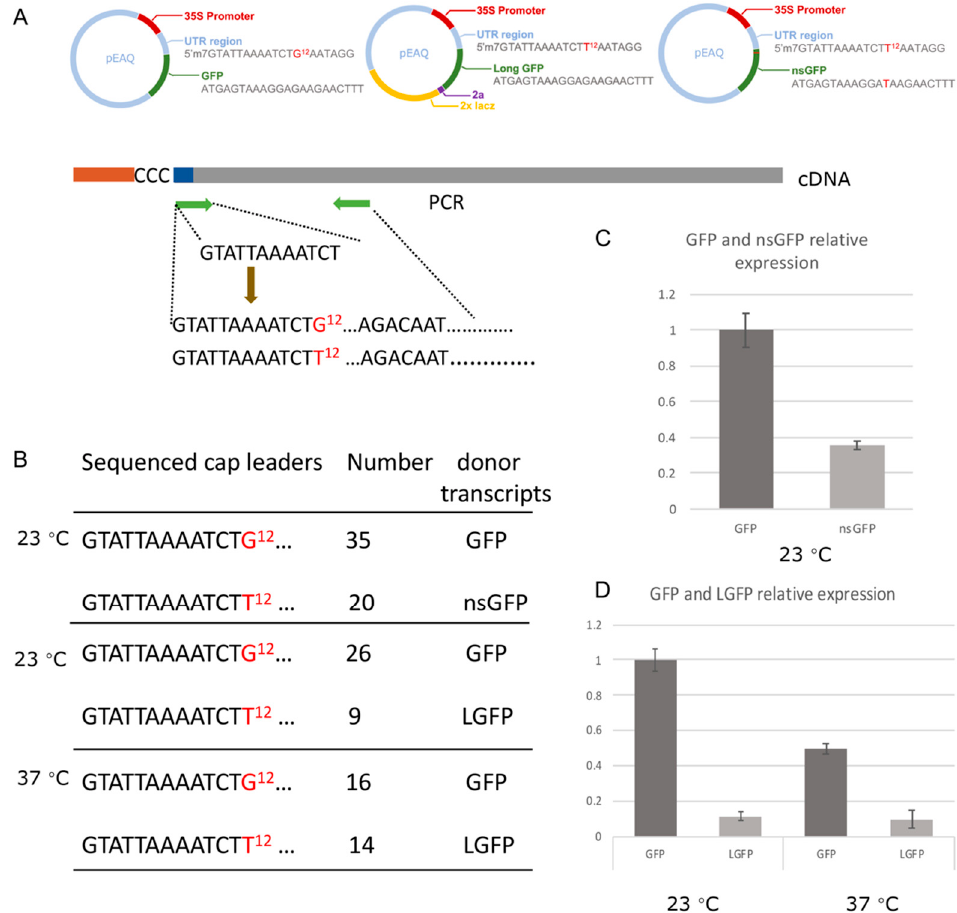
Figure 9. The cloning and identification of capped leader sequences snatched from provided tran- scripts. ( A ) Schematic overview of GFP, nsGFP and LGFP constructs and the cloning strategy of TSWV mRNA leader sequences. ( B ) The relative distribution of snatched leader sequences collected during in vivo cap donor competition assays between GFP, nsGFP and LGFP transcripts, respectively, at standard condition (23 °C) and heat stress condition (37 °C). ( C , D ) Expression levels of GFP, nsGFP and LGFP transcripts as determined by qRT-PCR.